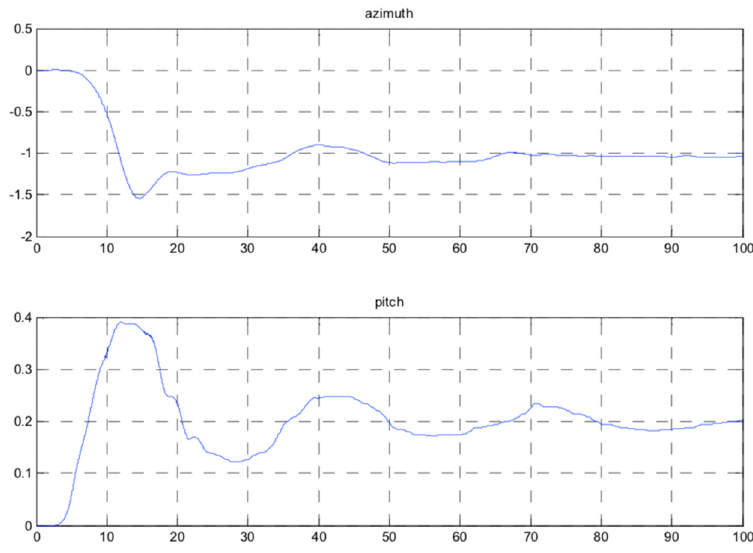
Figure 21. Experimental results of self-tuned FO-PI controllers for a twin-rotor system.